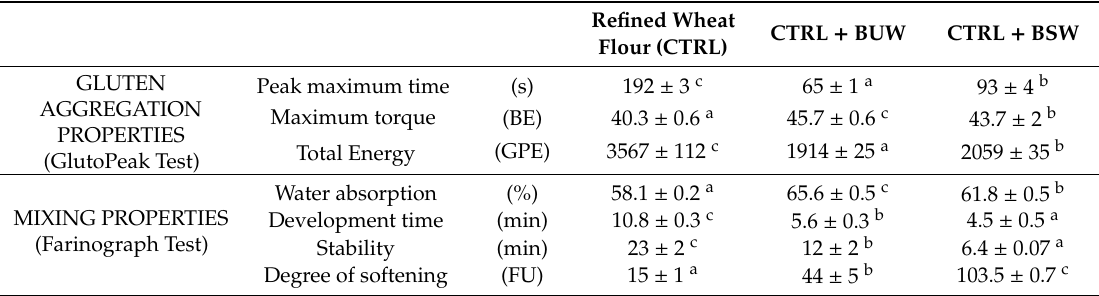
Table 2. Gluten aggregation and mixing properties of refined wheat flour alone, with bran from un- sprouted wheat, or bran from sprouted wheat.